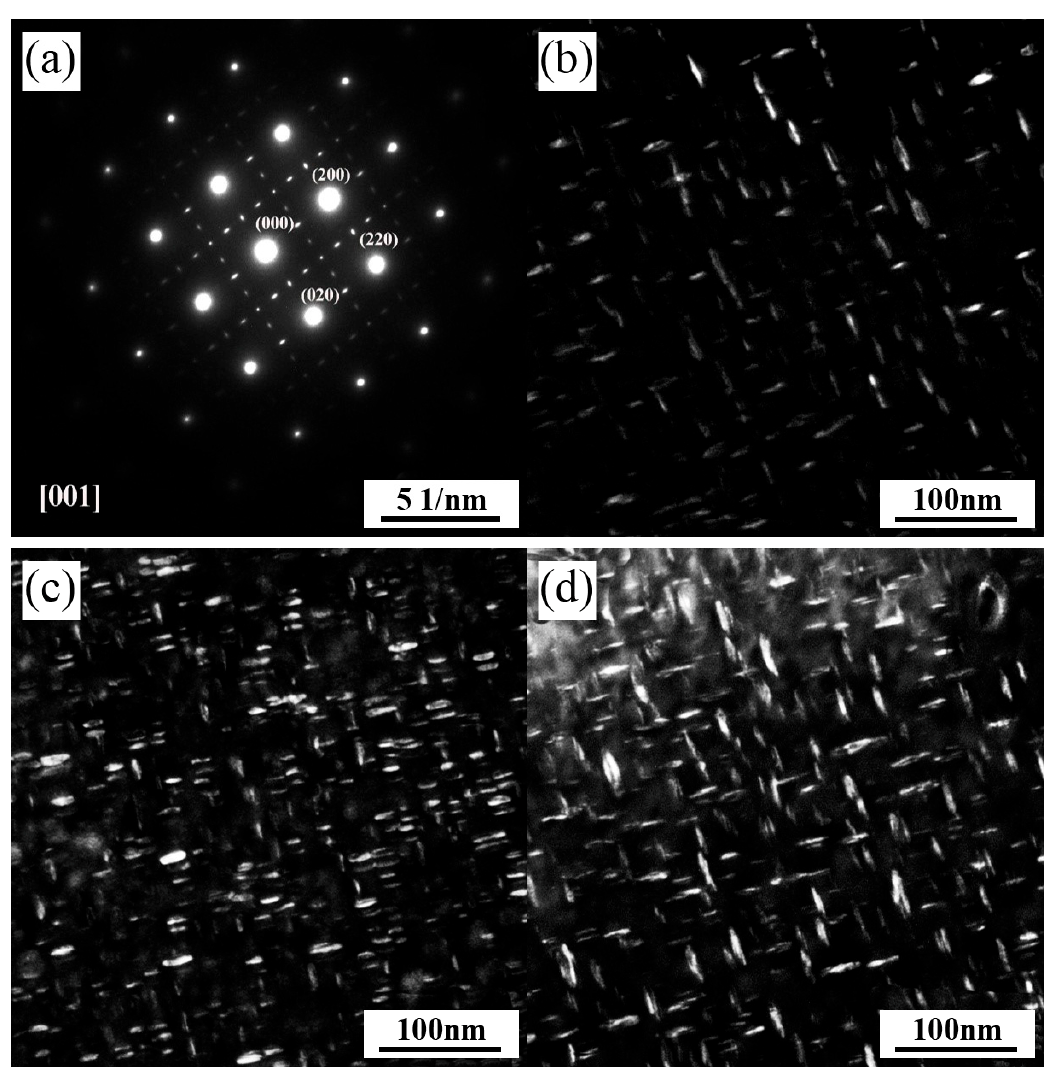
Figure 4. TEM images of the Inconel 718 superalloys showing γ ” phase: ( a ) selected area electron diffraction (SAED) pattern, dark field images for sample ( b ) SHT, ( c ) HIP + STA, and ( d ) HIP + DA.